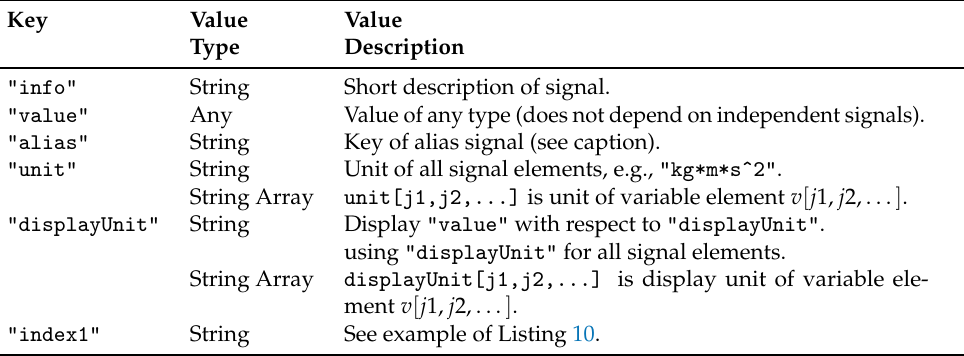
Table A2. Predefined attributes for Par dictionaries. Either "value" or "alias" must be present. Dur- ing the construction of a signal table, all Par with the attribute "alias" are automatically processed and obtain a "value" key that references the "value" key of the alias variable. As a result, "value" is present for all Par dictionaries after the construction of a Signal Table. All other keys are optional.